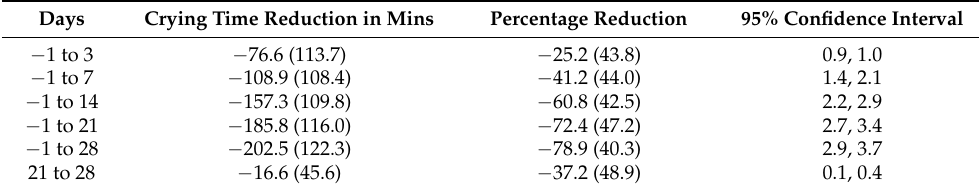
Table 1. Analysis of reduction in crying time, n =